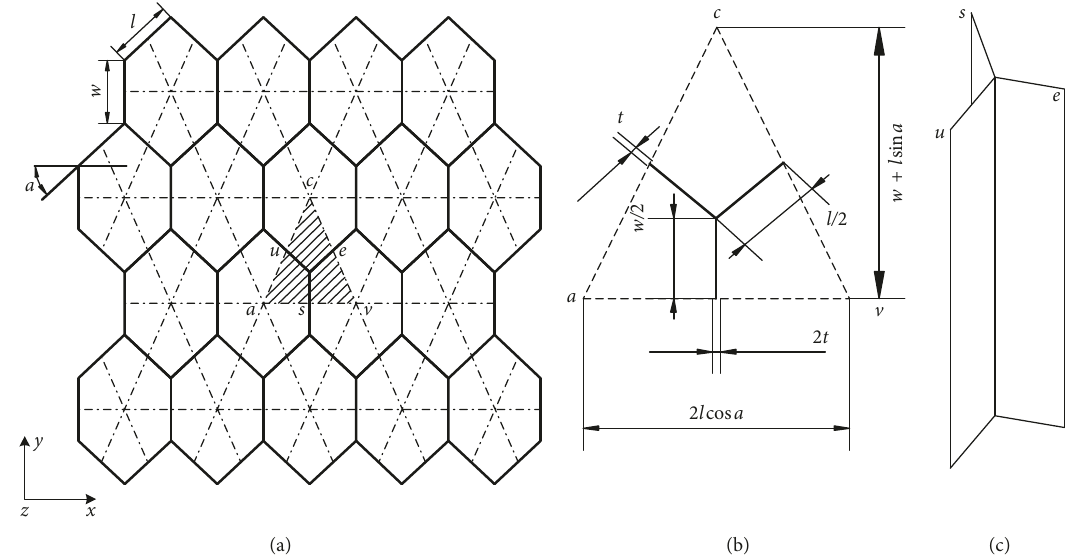
Figure 2: Analytical model of hexagonal honeycomb structures. (a) Sectional view of hexagonal honeycomb structures. (b) Sectional view of a “Y” cell model. (c) “Y” cell model map.